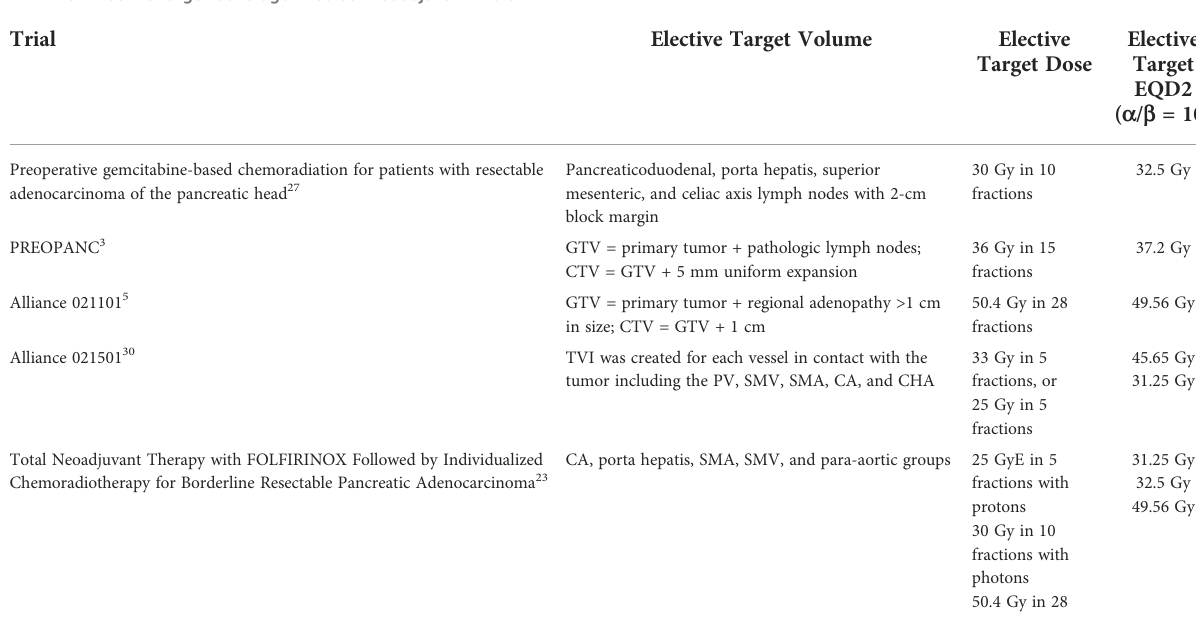
TABLE 3 Elective target coverage in select neoadjuvant